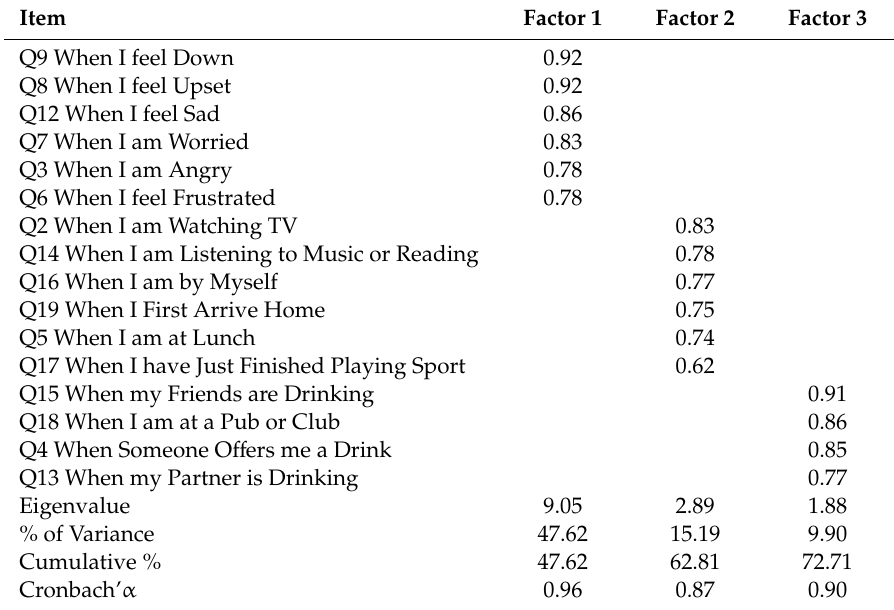
Table 1. Factor analysis for Drinking Refusal Self-E ffi cacy Questionnaire-Revised